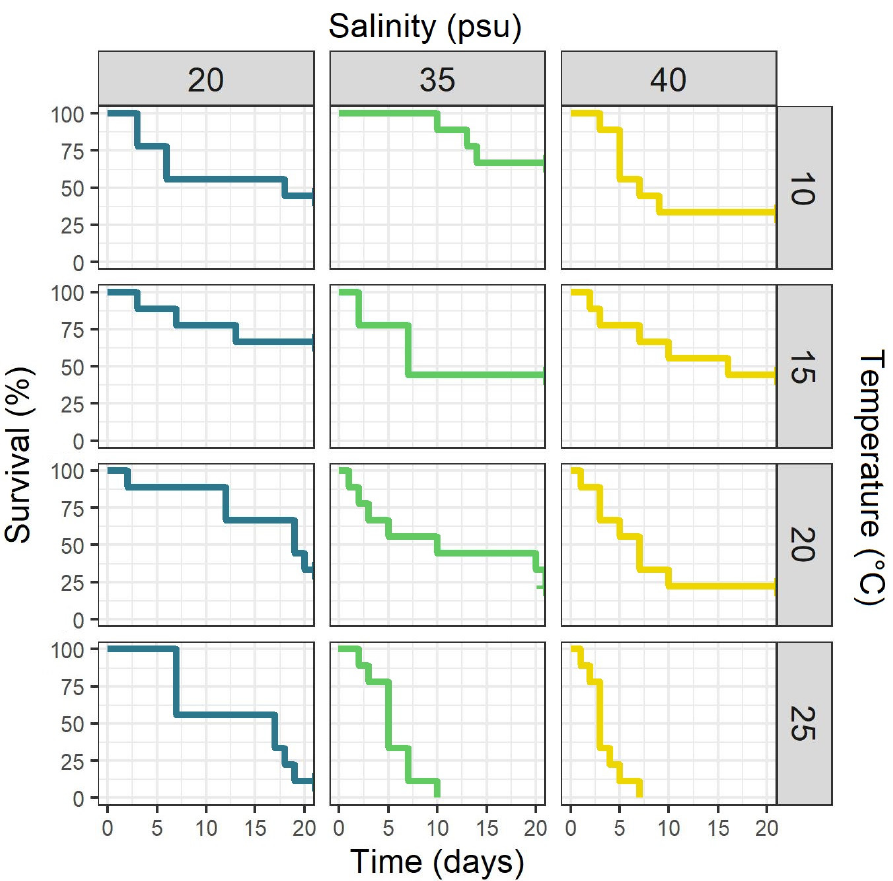
Figure 4. Kaplan–Meier survival curves for Aurelia solida ephyrae that were kept at twelve different combinations of temperatures and salinities over 21 days of the experiment ( n = 9 per combination).